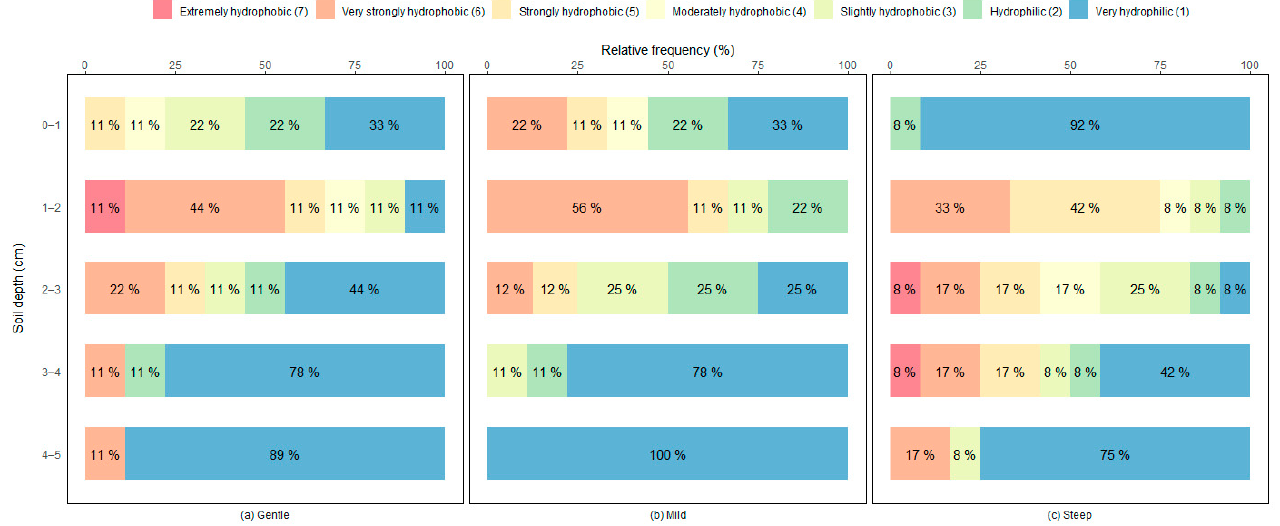
Figure 6. Relative frequency (%) of water repellency classes by soil depths, which were measured by MED tests at different slope gradient groups: ( a ) gentle, ( b ) mild, and ( c ) steep slopes. Table 3. Proportion of hydrophobic class of MED test by soil depths and the results of Fisher’s exact test on slope gradient.